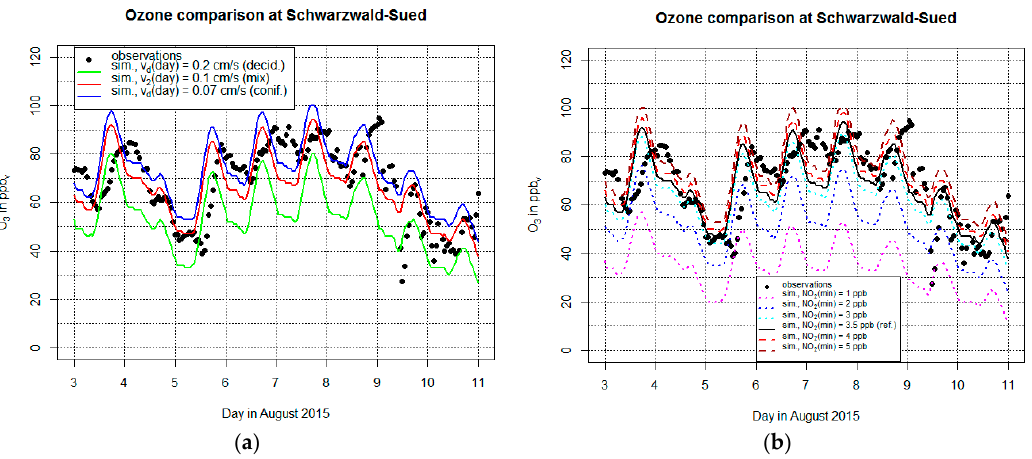
Figure 2. Comparison of observed and simulated ground level ozone volume mixing ratios at the remote reference site in the Black Forest. Dots display observed ozone values and lines display simulated ones. Different lines show the NO 2 effect on ozone, relying on air mass history, which is unknown for the box model. ( a ) Sensitivity runs for different ozone deposition velocities; ( b ) Sensitivity for different minimum NO 2 mixing ratios during the formation process.